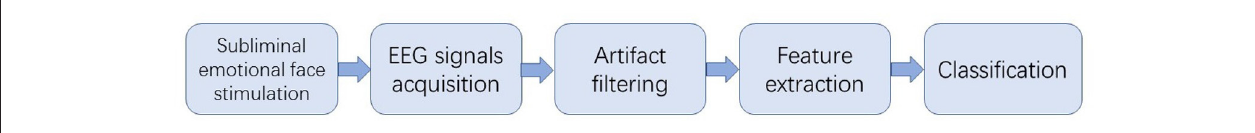
FIGURE 1 | The process of subliminal emotion classification.